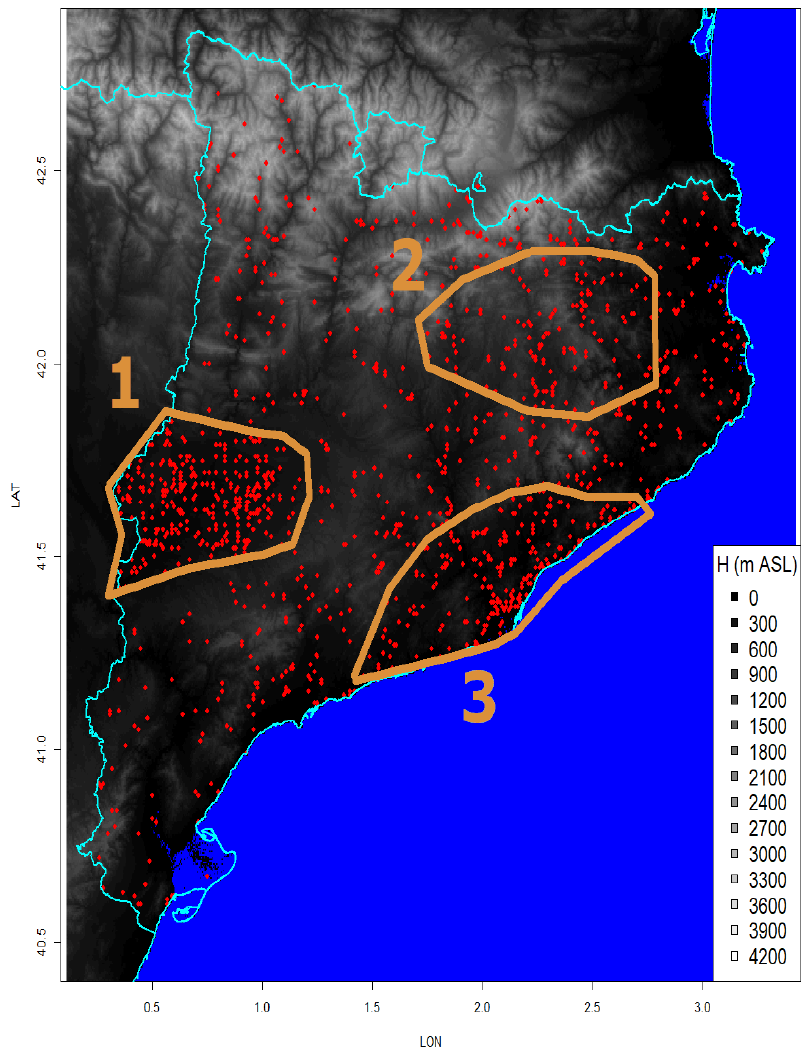
Figure 10. Same as in Figure 3, but with areas with the maximum number of registers. 1: the Western Plain, 2: the Central Pre-Pyrenees, 3: the Metropolitan Area of Barcelona.